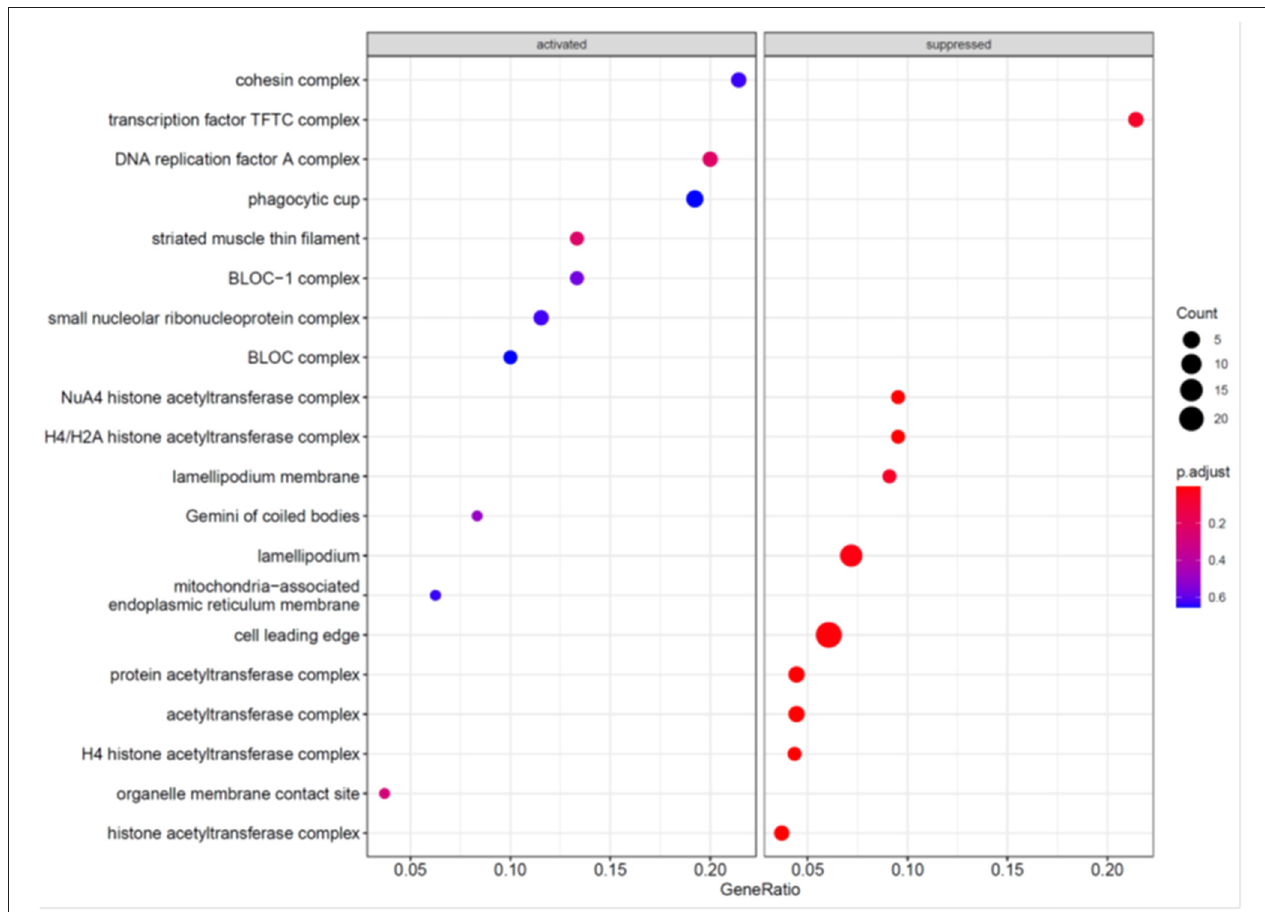
FIGURE 8 | GO_CC analyses of genes regulated in the podocytes deficient in